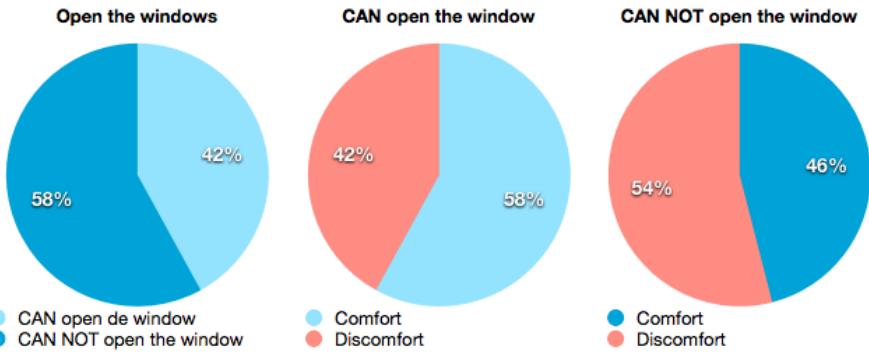
Figure 6. Question: what do you usually do in order to restore your comfort conditions?